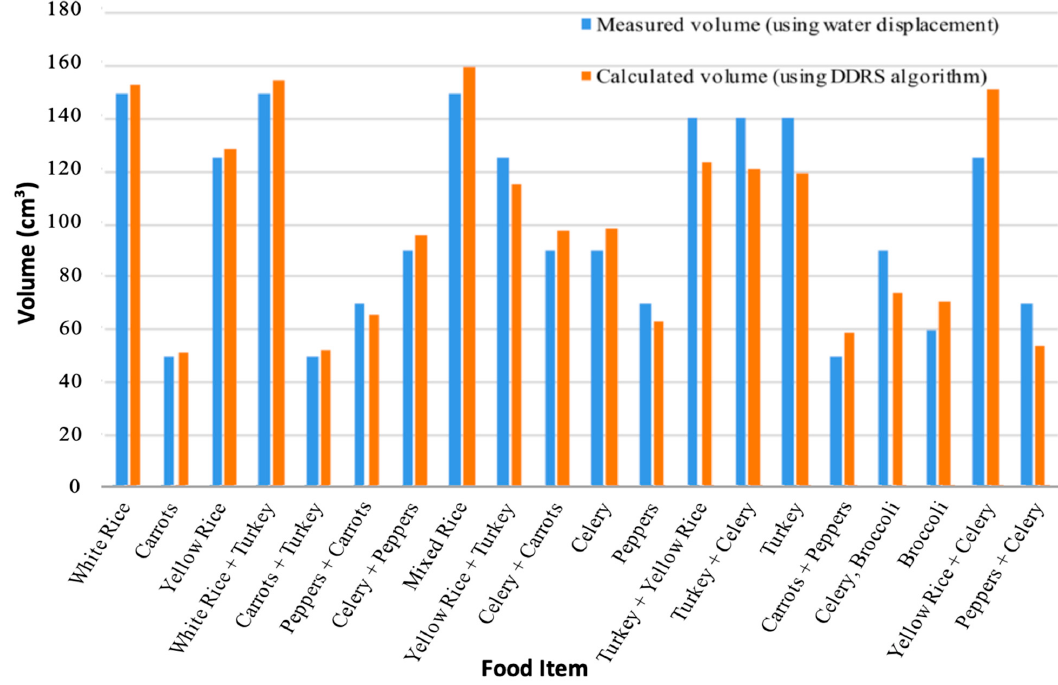
Figure 17. Measured volume using the DDRS algorithm vs. the calculated volume using water displacement.